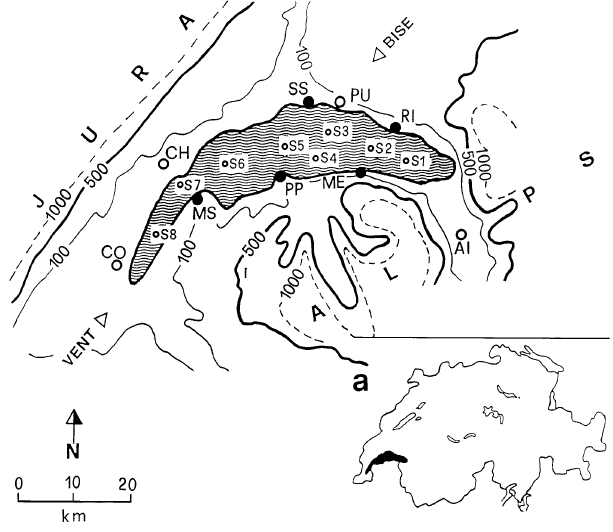
Fig. 1. Lake Geneva and its surroundings. The lake level (348 m above sea level) is taken as reference for all heights or depths indicated. Locations of temperature profiling stations ( S (cid:49) to S (cid:56) ) and of wind measuring stations are indicated. Letters represent: AI